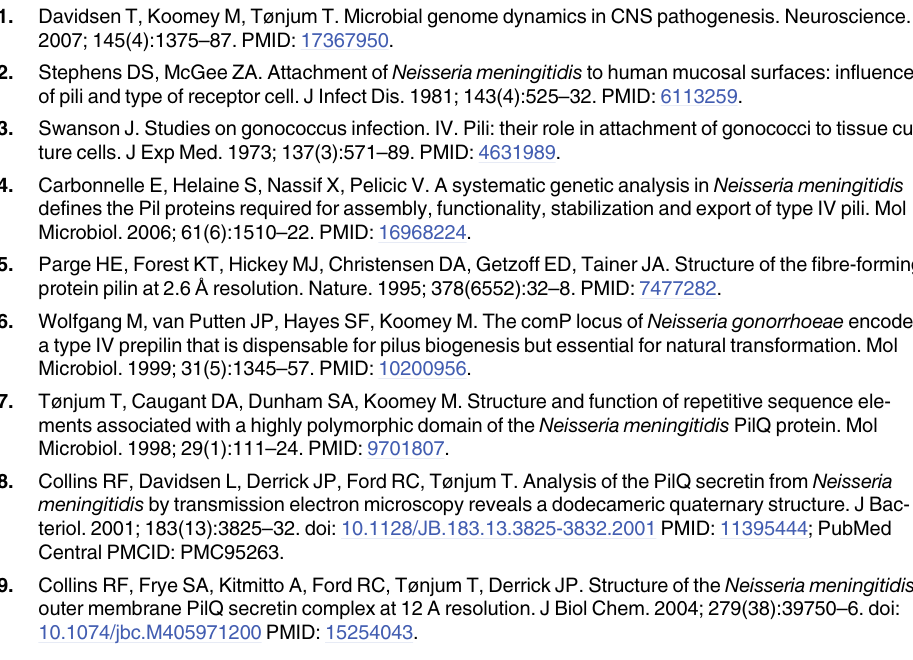
S10 Fig. Expression of Neisseria meningitidis strain MC58 PilE and PilG proteins moni- tored by immunoblotting. (A) Western blot of pilus preparations with anti-PilE antiserum. (B) Western blot of whole cell lysates with anti-PilG antiserum. Sampled clones and protein amount per lane are indicated on top. MC58 wild type (WT), MC58 Δ pilG ( Δ G), MC58-pilG: indicate (A) PilE and (B) PilG specific bands. The positions of the molecular size markers are shown in kDa on the left. S1 Table. Oligonucleotides. Primers employed in PilG recombinant protein construction and alanine substitution mutants. S2 Table. Recombinant proteins. Expression and purification of PilG recombinant